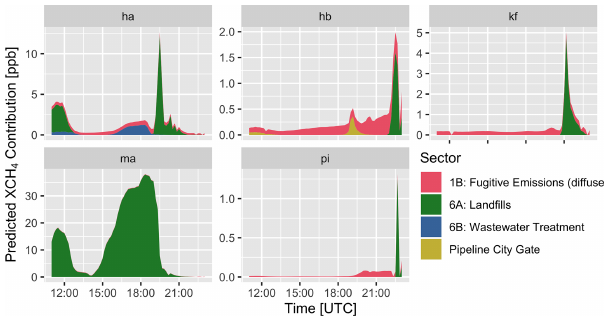
Figure 4. Predicted XCH 4 contribution to each measurement from each source for 13 May. These values are computed by multiplying the STILT footprints by the a priori